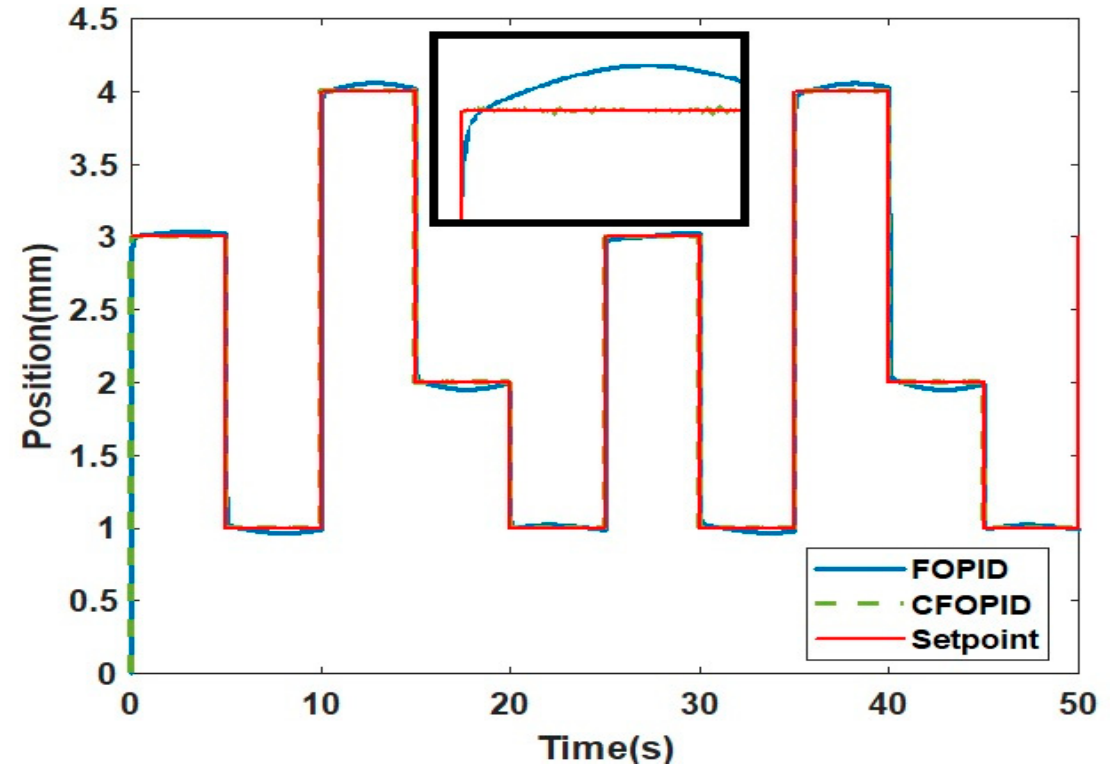
Figure 14. The CFOPID and FOPID controllers’ responses with varying setpoint. Additionally, the outcomes are contrasted with those from studies that used the generalized predictive controller (GPC) presented in [36], the model predictive controller (MPC) presented in [37], and the predictive functional controller (PFC) with the novel observer method presented in [14] for the same system in order to show the superiority of the CFOPID controller. Table 6 displays the results obtained from using these controllers. Table 6. Comparison between the CFOPID and other controllers’